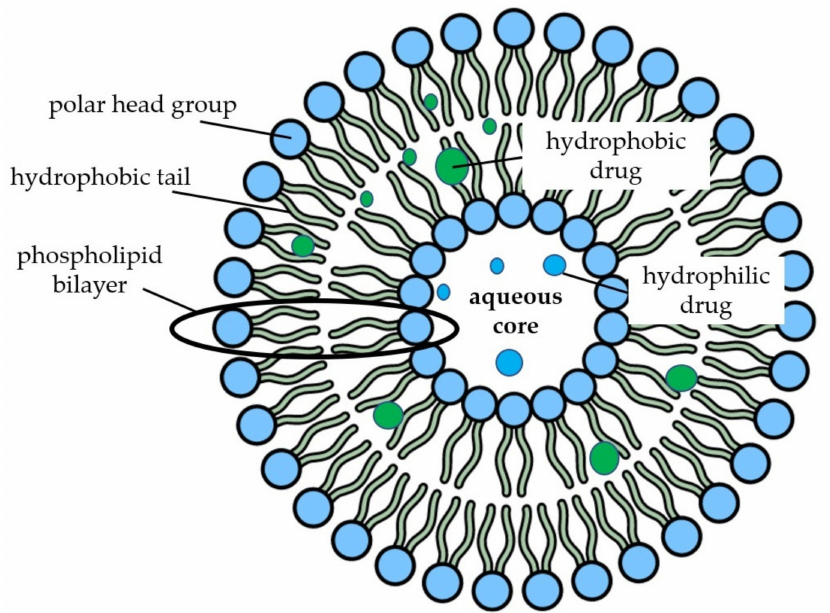
Figure 4. Schematic representation of nanoliposomes containing hydrophilic and hydrophobic entrapped